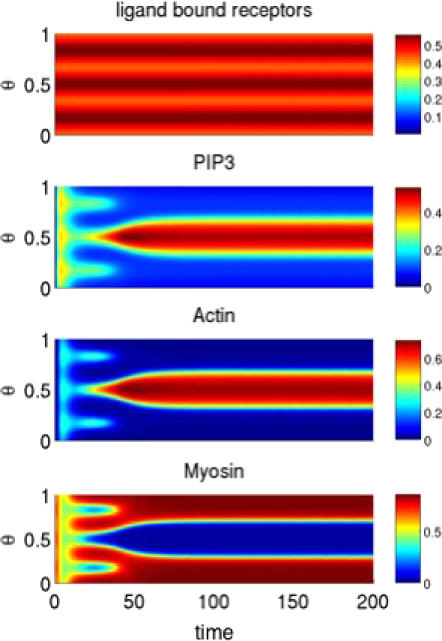
Triple Micropipette ExperimentThree gradients of equal intensity (bL = 1 and gL = 0%) are placed equidistantly around the cell.